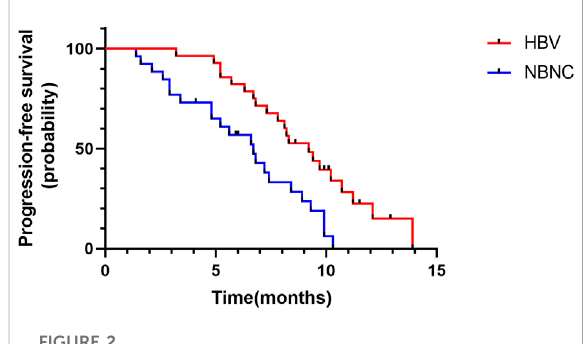
FIGURE 2 Kaplan – Meier plot of progression-free survival in the HBV – HCC and NBNC – HCC groups.